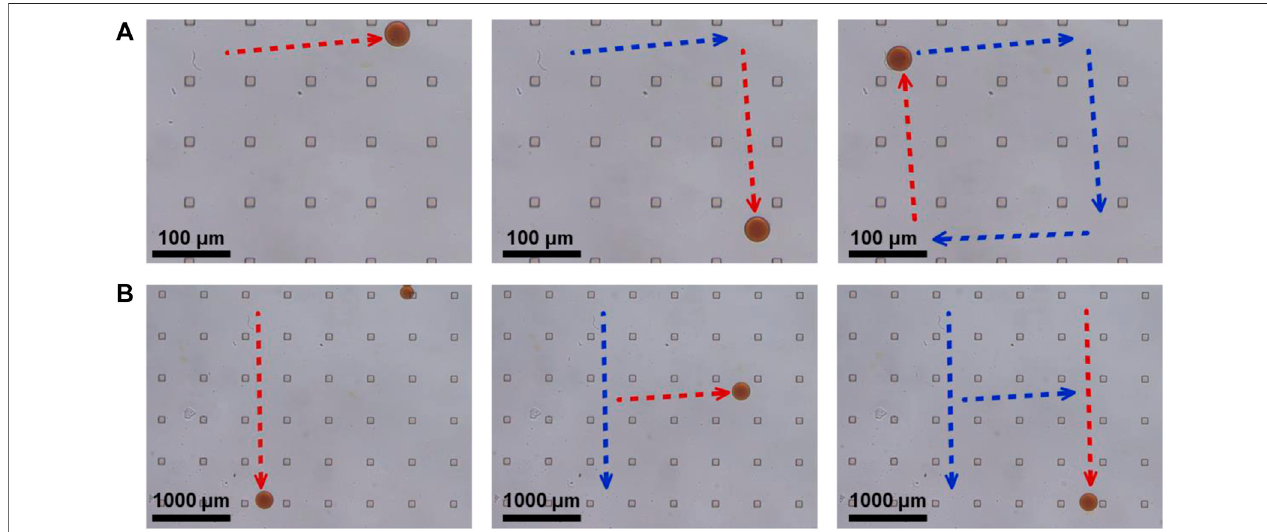
FIGURE 4 | Predetermined locomotion of magnetic-driven hydrogel microrobots. (A) The microrobot was driven by the predetermined direction of a square. (B) The microrobot was driven by the predetermined direction of letter H.